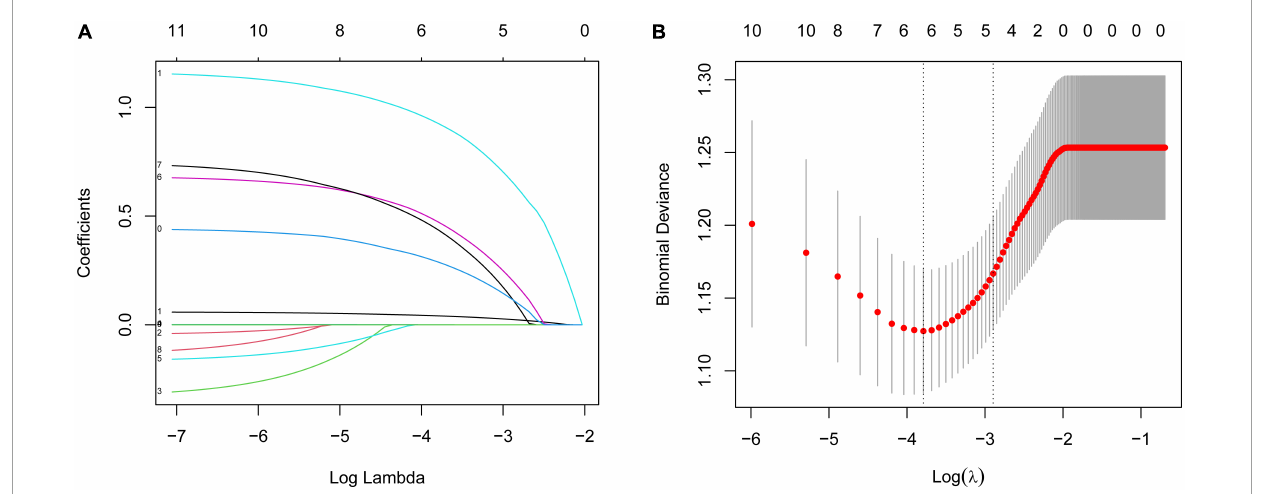
FIGURE2 (A) Variable selection by LASSO regression model. A coefficient profile plot was produced against the log(lambda) sequence. Each curve corresponds to a variable. It shows the path of its coefficient against the L1-norm of the whole coefficient vector at various λ values. (B) Partial likelihood deviance for the LASSO coefficient profiles. The red dotted line stands for the cross-validation curve, error bars represent the upper and lower standard deviation curves along the λ sequence. Five variables with non-zero coefficients were found by optimal λ ( λ = 0.05527638).